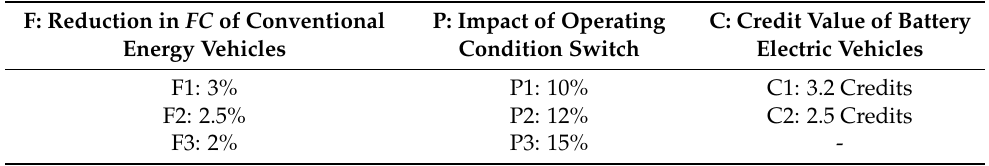
Table 3. Main input parameter scenarios of the policy impact model.